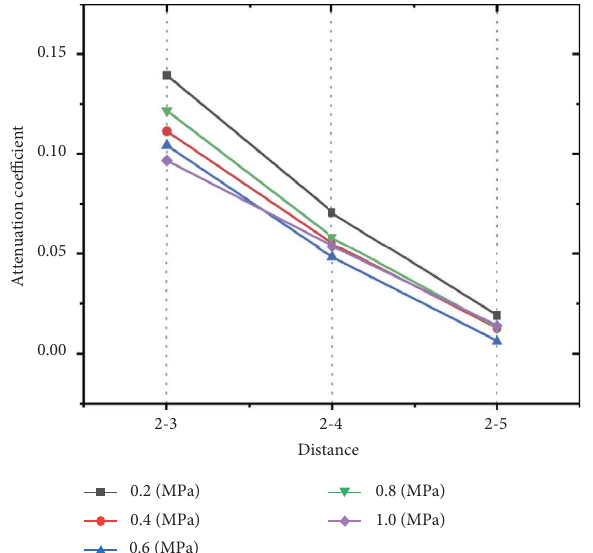
Figure 12: Variation law of the attenuation coefcient between points A and D under diferent